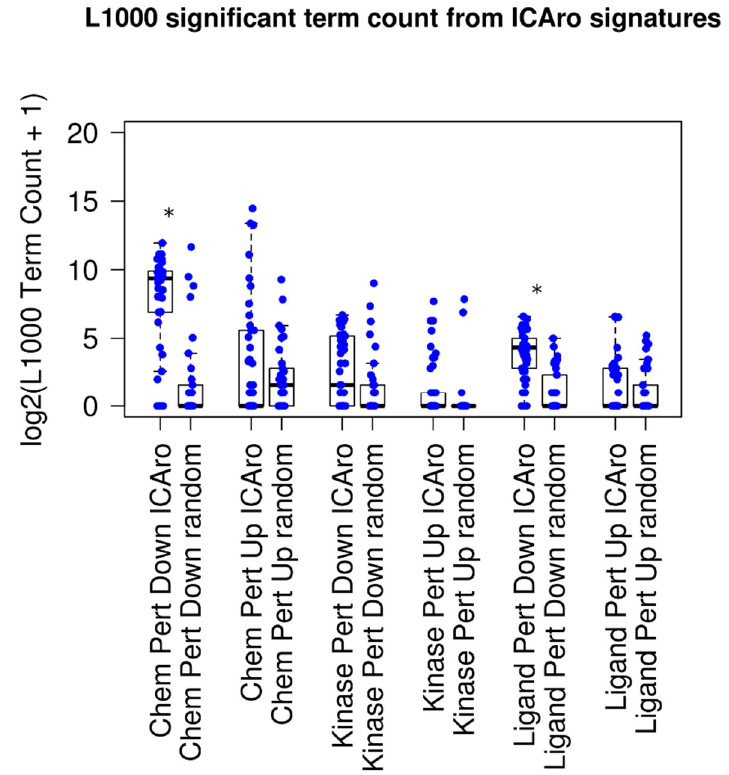
Figure 3. The amount of significant terms for down and up-regulated genes when compared to L1000 signatures: Every point is an ICAro execution with a significant gene set (up or down). Every signature is compared with the amount of significant terms when sampling random gene sets of equal size. Legend: * significant increase between random sampling and ICAro.